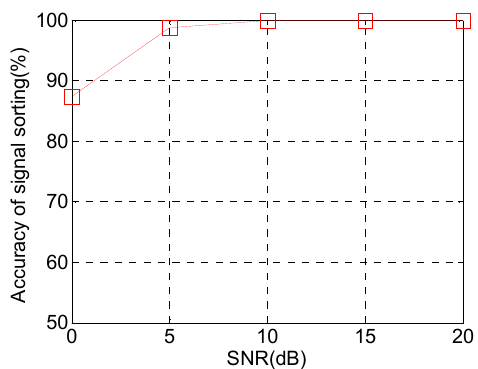
Figure 9. Accuracy of signal sorting in different SNRs.